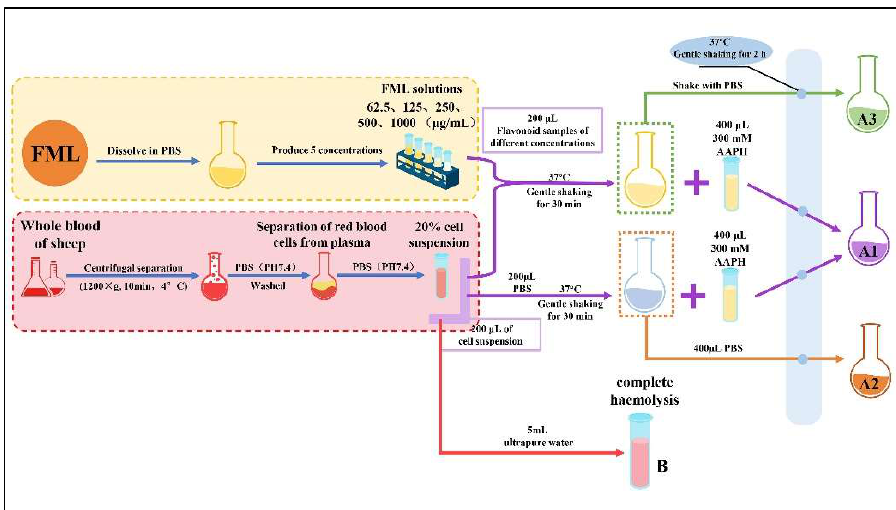
Figure 2. The procedure for the AAPH-treated erythrocyte hemolysis